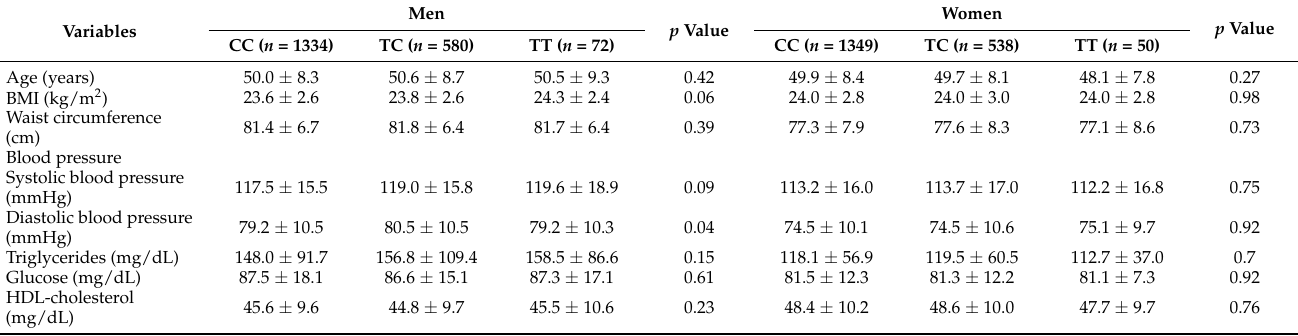
Table 2. General characteristics of the study participants based on the SLC35F3 rs10910387